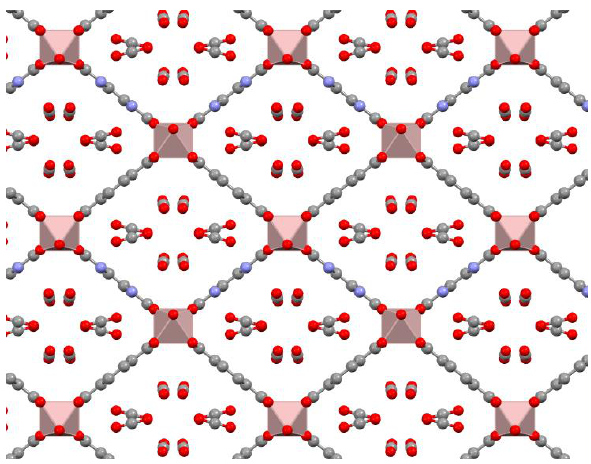
Figure A1. View of the structure of the as-prepared NH 2 -MIL-53(Al) along a axis. Due to the